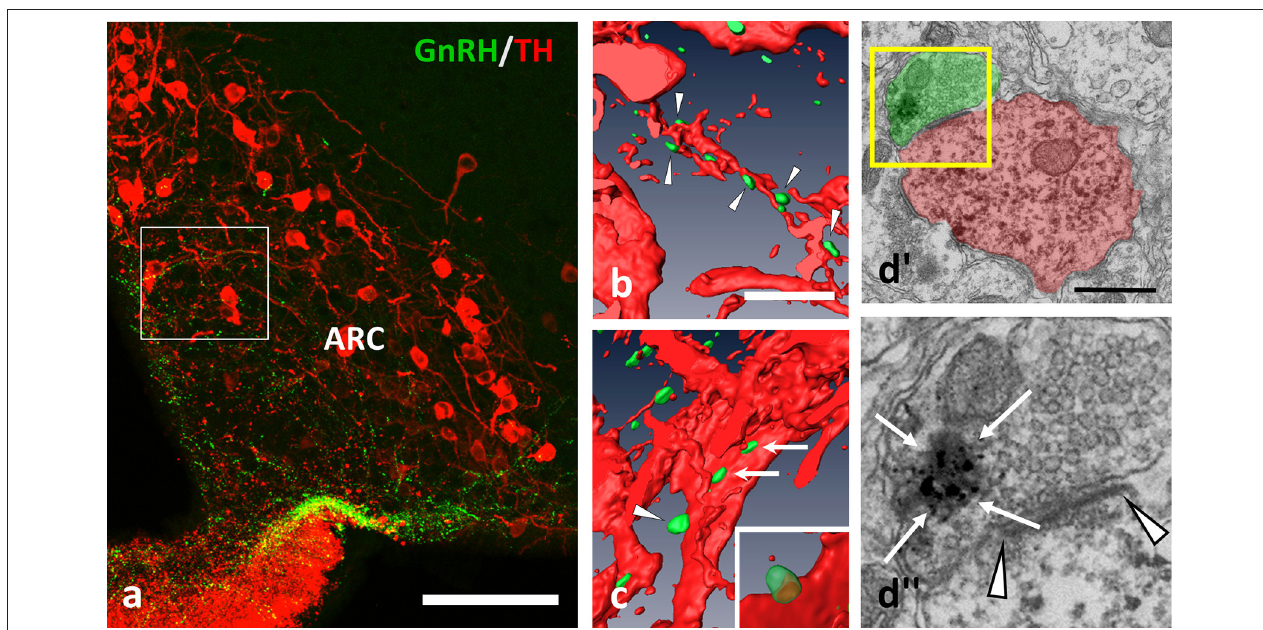
FIGURE 2 | GnRH-IR varicosities (green) establish multiple appositions on TH-IR neurons (red) also in the Arc. (a–c) Axo-dendritic and axo-somatic appositions are indicated by arrowheads and arrows; (b,c) are snapshots from the 3D reconstructed and rotated image of the boxed area in (a) . The presence of asymmetric synapses (d ; arrowheads) were confirmed also by the arcuate appositions. (d) ” The GnRH-IR axon terminal contained both dense-core granules (arrows, heavily labeled with SGI-NiDAB) and round-shaped, small, clear vesicles, as shown in the high power image of the boxed area of (d) ’. Scale bar in (a) is 100 µ m; in (b) and (c) 10 µ m; in (d ’ ) it is 500nm.